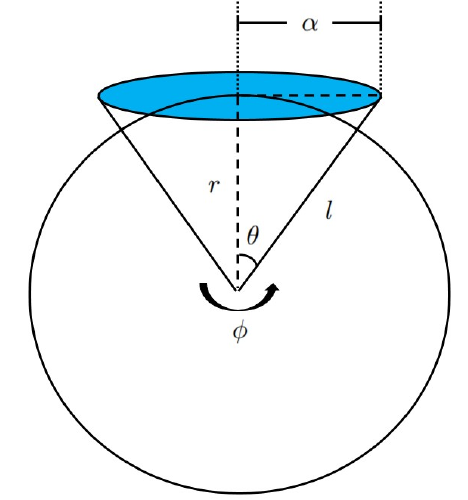
Figure A1. A schematic of a cone embedded into a sphere, illustrating the approximation of a small region of a two-sphere as a flat disk. The relative size of the disk (blue) has been exaggerated for clarity.